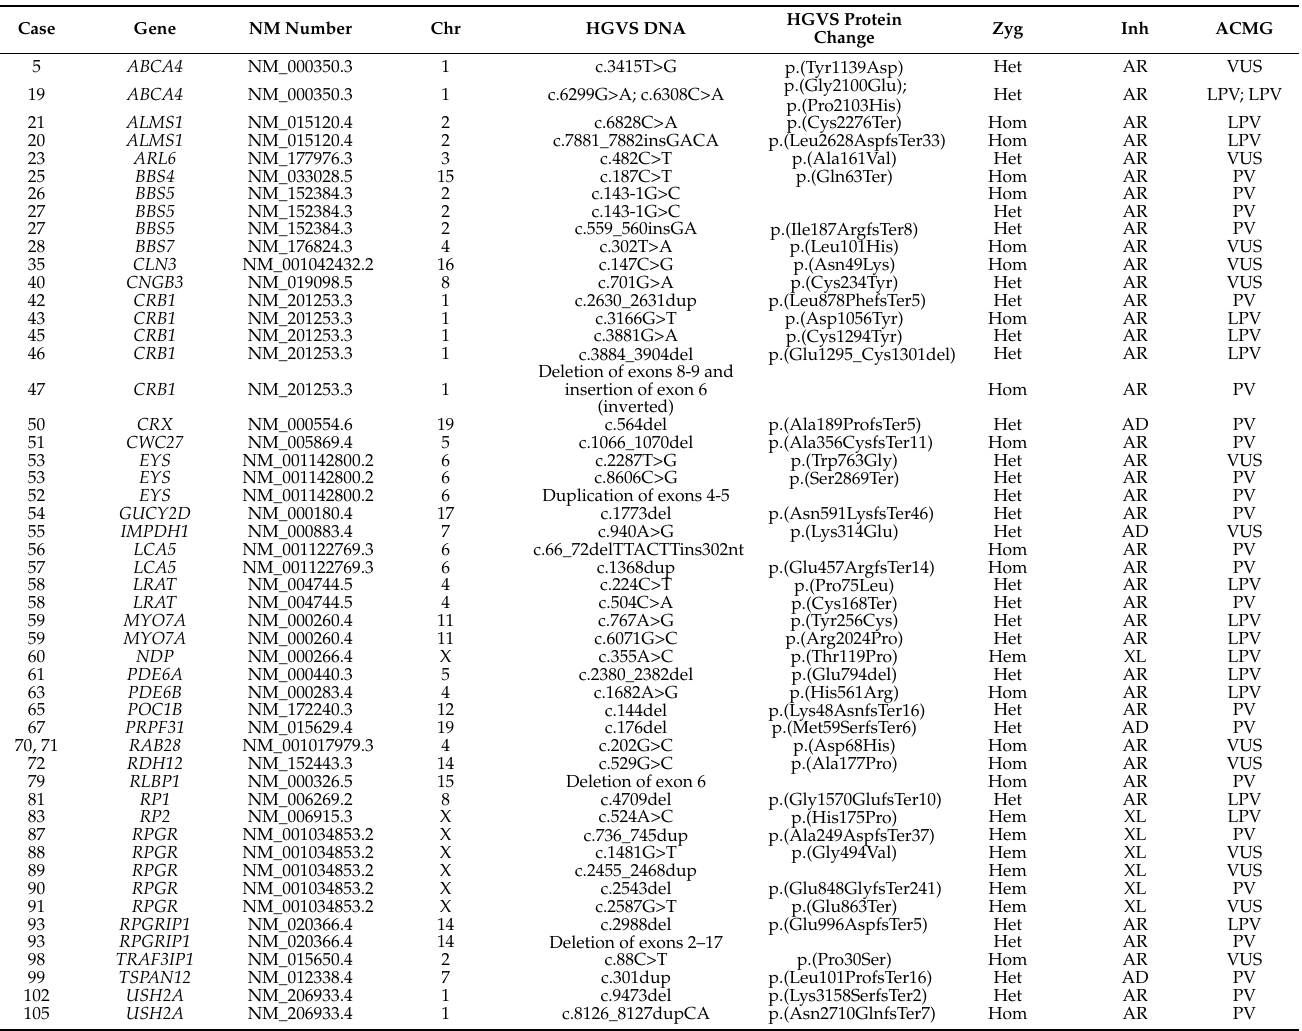
Table 1. Newly identified putative pathogenic